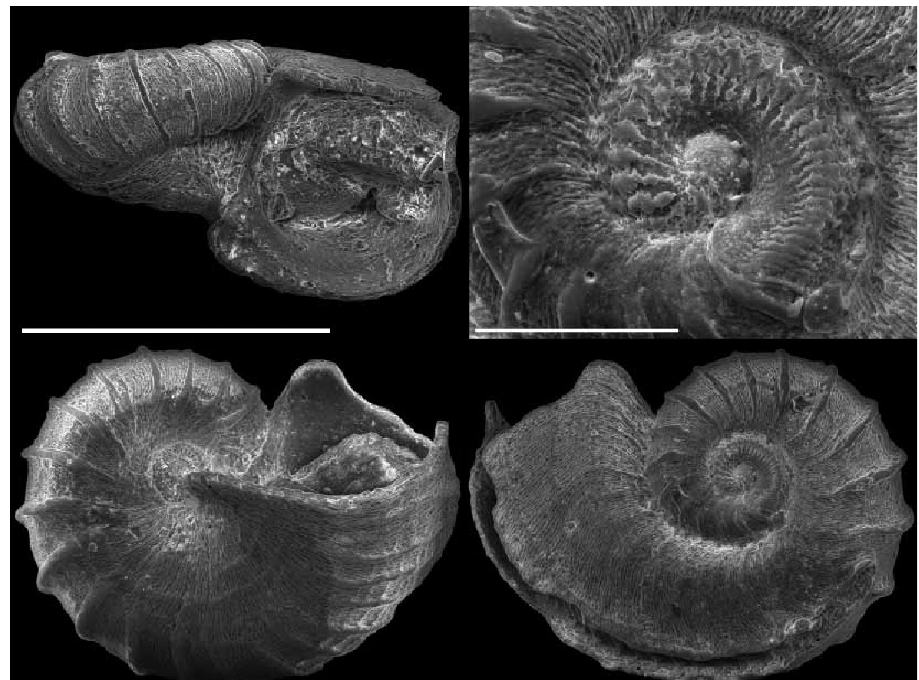
Figure 19. Scissurella maraisorum Geiger, 2006. Holotype T1616/NMSA-MOL 0W3498. Scale bars shell: 500 μm, protoconch: 100 μm. After Geiger (2006: 10, figure 7).